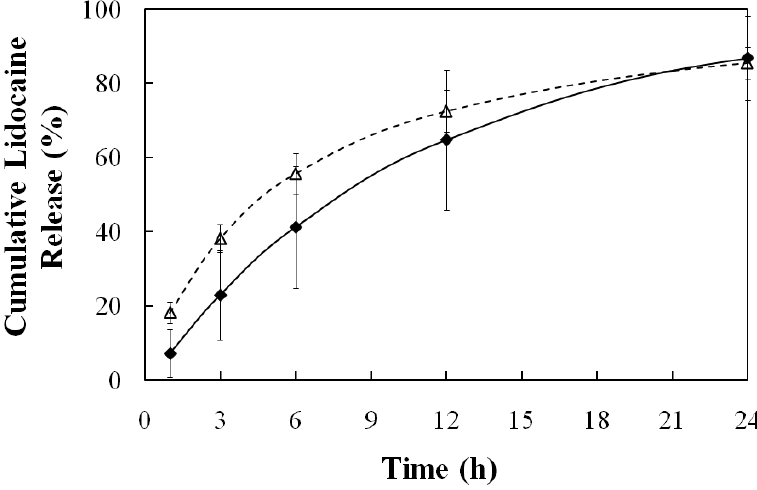
Figure 12. Release profile at room temperature (25 ± 1 °C) of lidocaine from pig skin after 30-minutes loading with: 20% gelatin MBG containing 3.1% lidocaine ( ♦ ), and gelatin-free, 6% SMO μ E containing 3.9% lidocaine ( ∆ ). See Table 1 for additional μ E composition